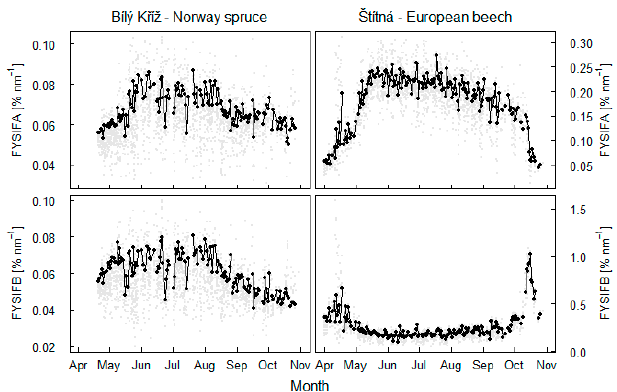
Figure 6. Dynamics in yield of fluorescence emission in O 2 A band (FYSIFA) and O 2 B band (FYSIFB). Mean value dynamics for a midday 2 h long period is shown with a black line. Grey points put into display values at 30 min intervals.